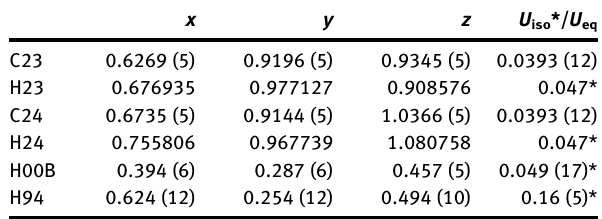
Table  : Fractional atomic coordinates and isotropic or equivalent isotropic displacement parameters (Å 